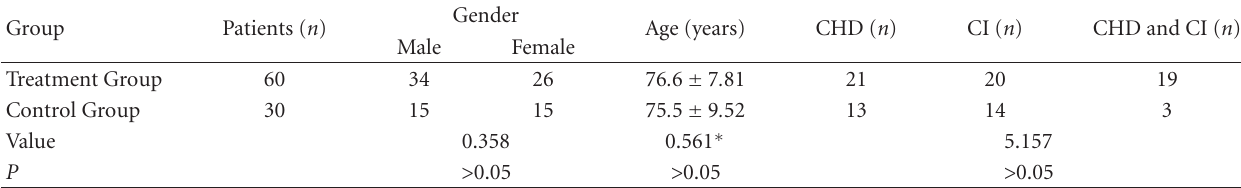
Table 1: General Information of the two groups ( X ±